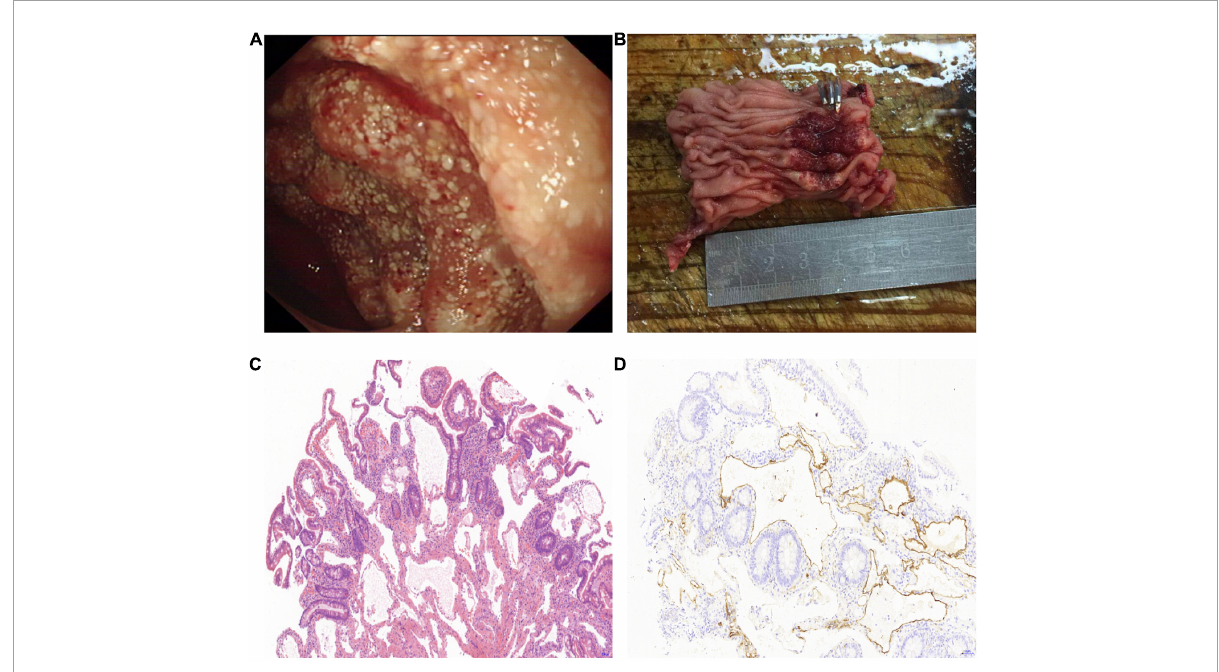
FIGURE1 Surgically resected lymphangioma of jejunum due to gastrointestinal bleeding. (A) An irregular protuberant lesion of 5.0 cm × 6.0 cm in the upper segment of the ileum, with white-colored spots on the surface. (B) Photograph of segmental ileal resection, including the lymphangioma lesions. (C) Morphology showing that the lesions were composed of variably sized cysts in the mucosal lamina propria and submucosa, and the lumen was filled with lymphatic fluid (hematoxylin–eosin staining, 10 × magnification). (D) D2-40 immunostaining shows positive reactivity for the endothelial cells lining the lymphatic spaces in the muscular layer (10 ×